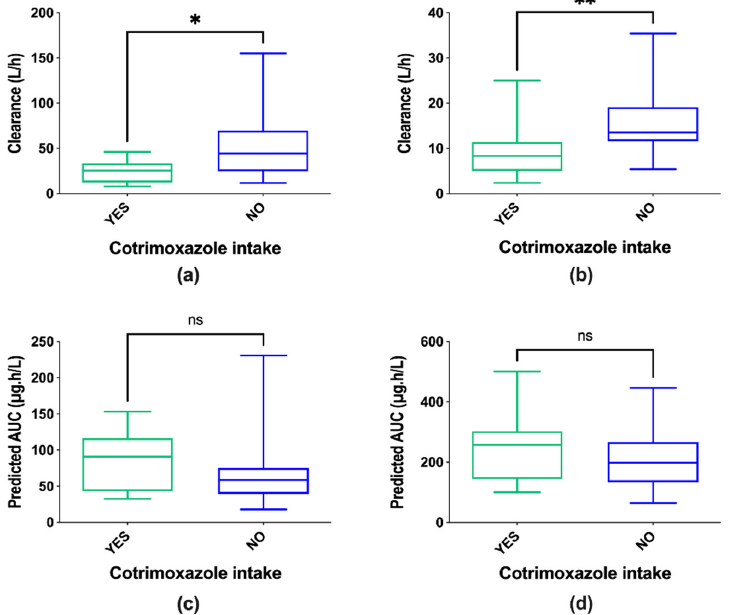
Figure 2. Clearance distribution on D1 ( a ) and D8 ( b ) with or without cotrimoxazole comedication. Exposures to sirolimus (predicted AUCs) were not statistically different on either D1 ( c ) or D8 ( d ) because of a trend of lower doses of sirolimus in patients who were on cotrimoxazole than in patients without cotrimoxazole prophylaxis. Statistical analysis: Unpaired t test, alpha = 0.05. * p < 0.05, ** p < 0.01, ns = no significant differences.